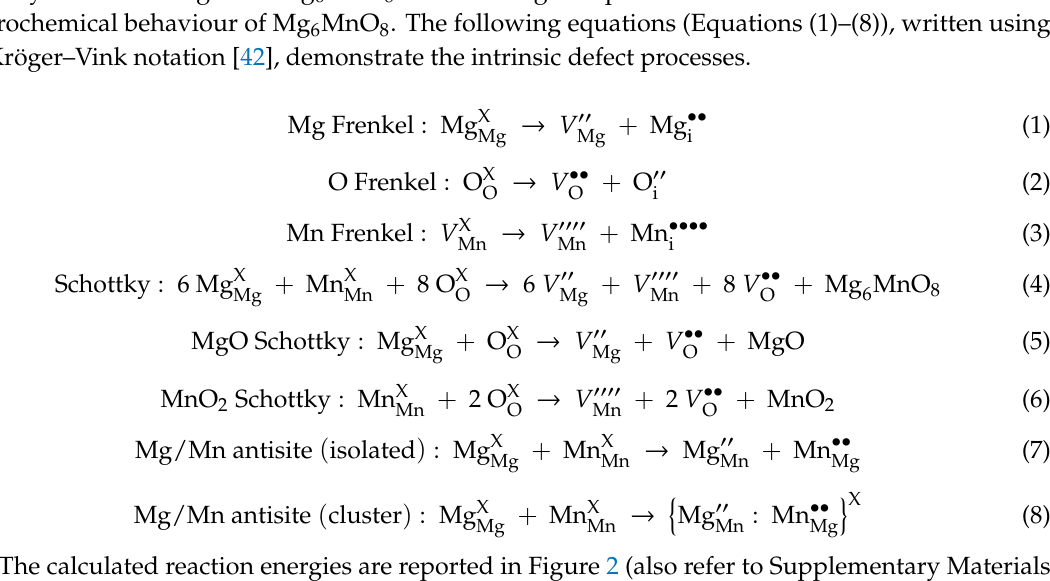
(cid:16) (cid:17) Fm 3 m